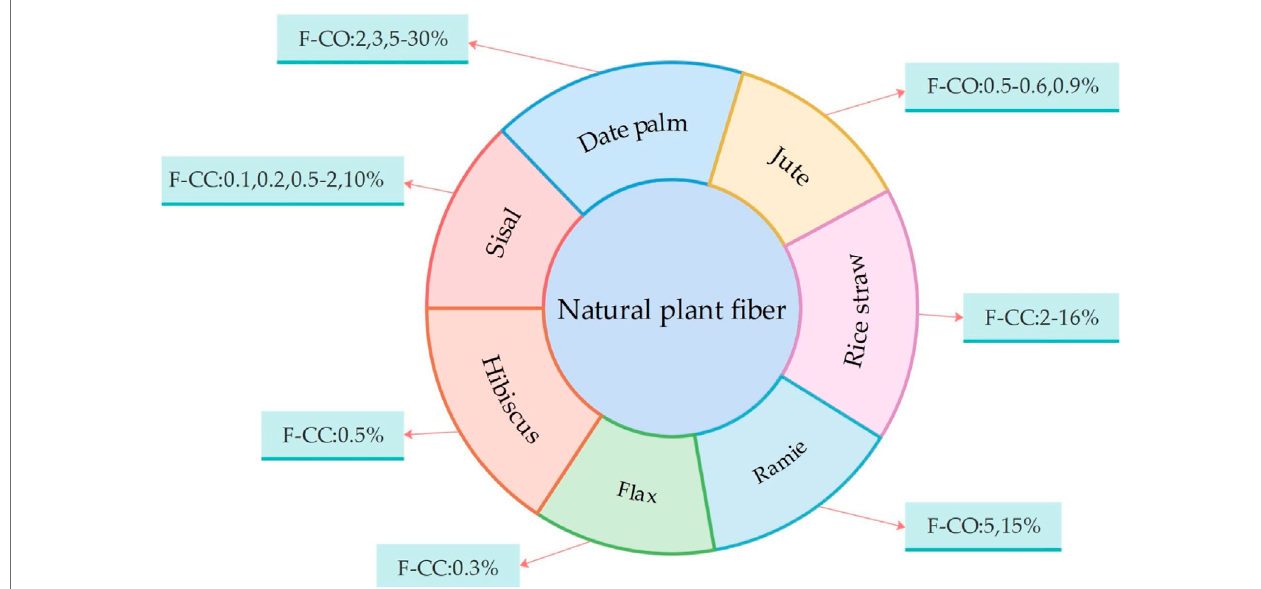
FIGURE 2 | Classi fi cation of aquaculture waste in the article.